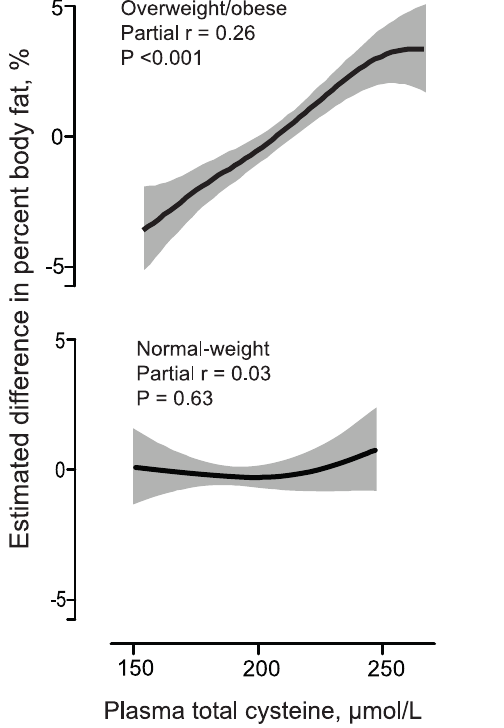
Figure 2. Association of tCys with body fat%. Dose-response curves (solid lines) with 95% confidence intervals (shaded area) for the association of plasma tCys with body fat% in normal weight (CDC-BMI percentile , 85 th ; N=288) and overweight/obese (CDC BMI percentile $ 85 th ; N=696) children and adolescents after adjustment for age and gender. P-values and partial correlation coefficients were obtained from corresponding linear regression analysis. Data is shown only for the 2.5 th –97.5 th percentiles of tCys for each group.